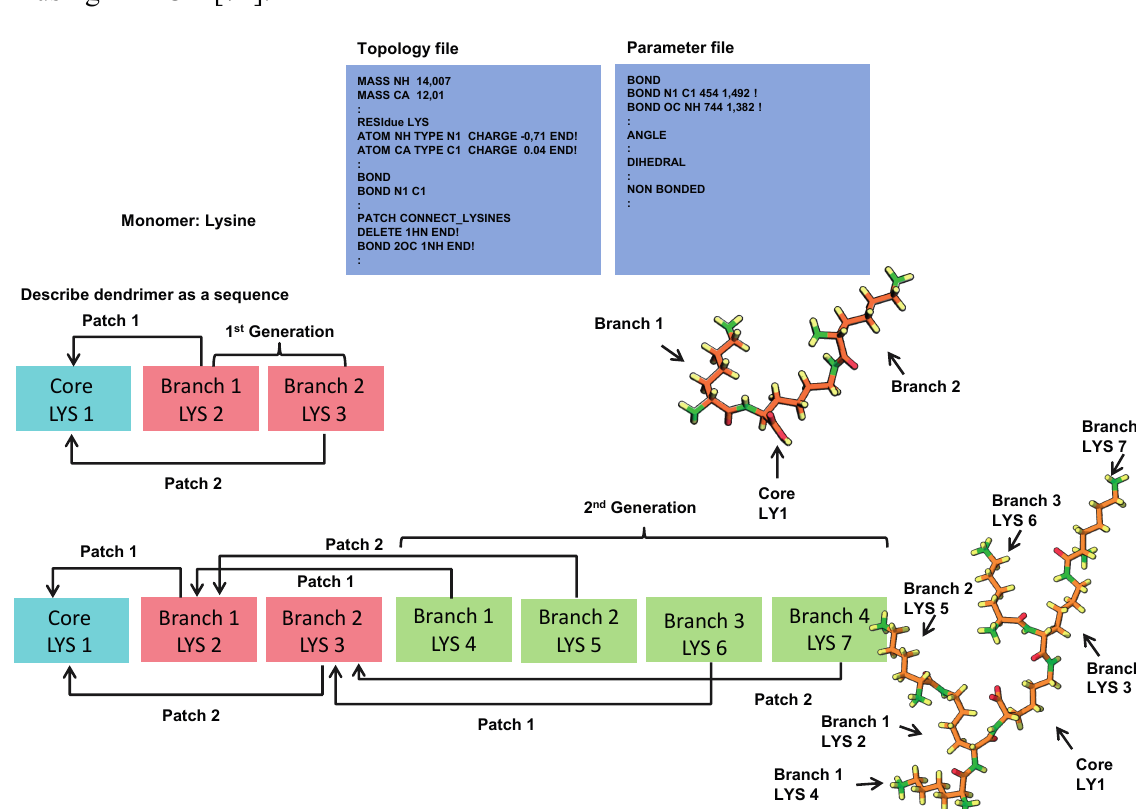
Figure 5. Strategy employed for building dendrimers of different types and generations using XPLOR